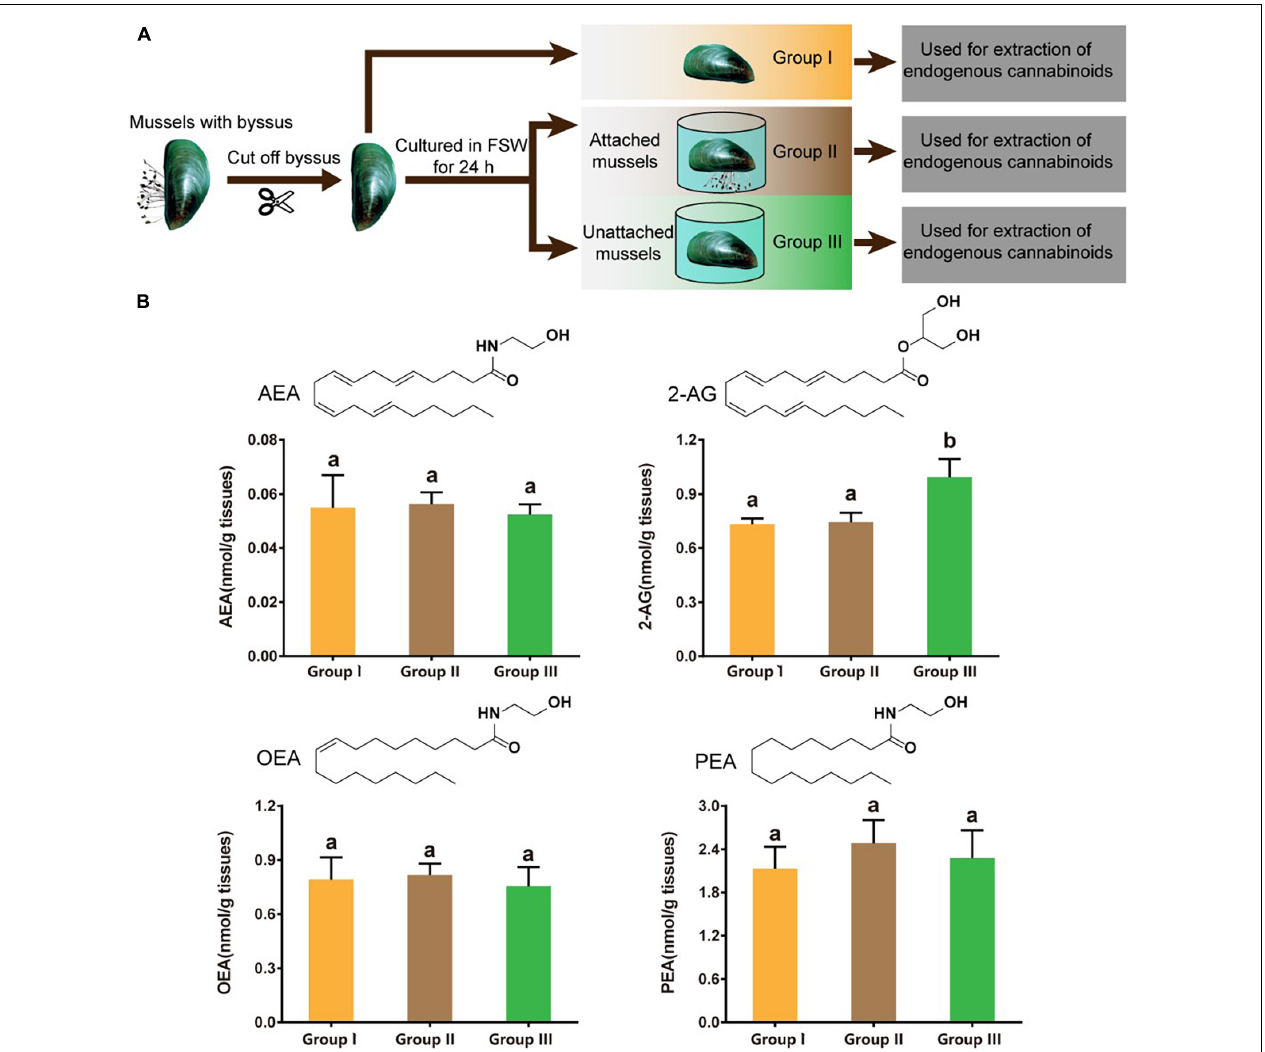
FIGURE 1 | 2-AG is present at significantly higher levels in unattached P. viridis . (A) Schematic illustration of the sampling for extraction of endogenous cannabinoids. (B) Comparison of amounts of AEA, 2-AG, OEA, and PEA in three groups of P. viridis . Group I: Mussels with the byssus removed. Group (cid:53) : Mussels that had the byssus removed and that were then incubated in FSW for 24 h and reattached. Group : Mussels with byssus removed, then incubated in FSW for 24 h and which remained unattached. Data shown are means + SE of replicates ( n = 8). Different letters above columns indicate significant differences among groups ( P <